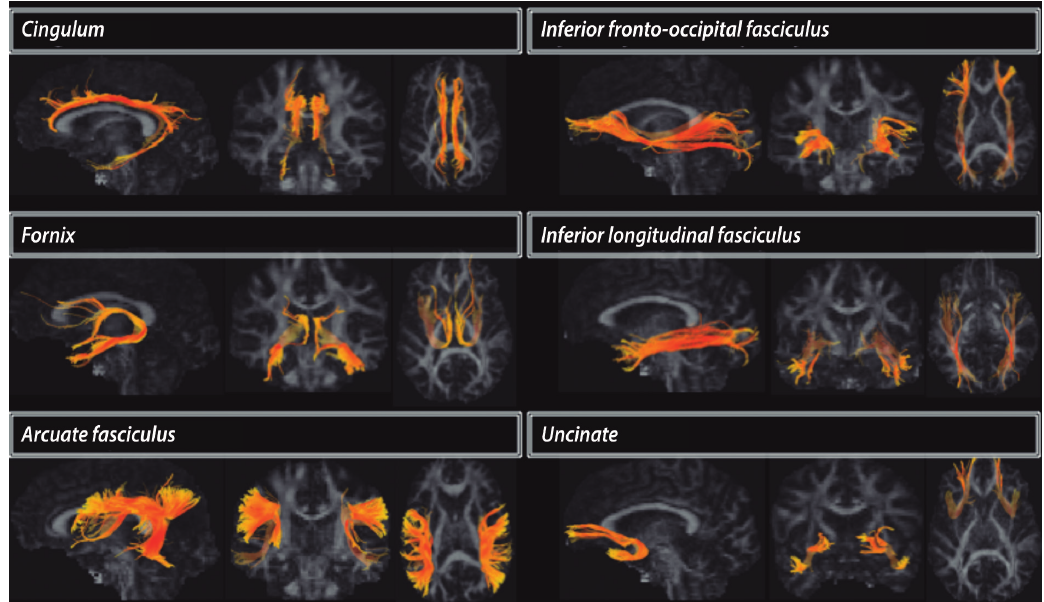
Figure 3. Reconstruction of WM tracts using DTI tractography. The cingulum is one of the most important components of the limbic system, and it has been associated with attention, temporal orientation, information processing and executive functions. The fornix also integrates the limbic system, con- necting the hippocampus and amygdala to the mammillary bodies and then to prefrontal regions through the anterior forebrain and thalamus. The arcu- ate fasciculus connects the posterior temporal and inferior parietal cortices to the frontal lobe, and it has been linked to primary and executive language functions and verbal memory. The inferior fronto-occipital fasciculus and the inferior longitudinal fasciculus have a partial spatial overlap, connecting the occipital cortex to the fronto-orbital and anterior temporal regions. They have been associated with visual memory, visuospatial functions and object rec- ognition. The uncinate fascicullus connects the temporal pole to fronto-orbital regions, being associated with memory, learning and information